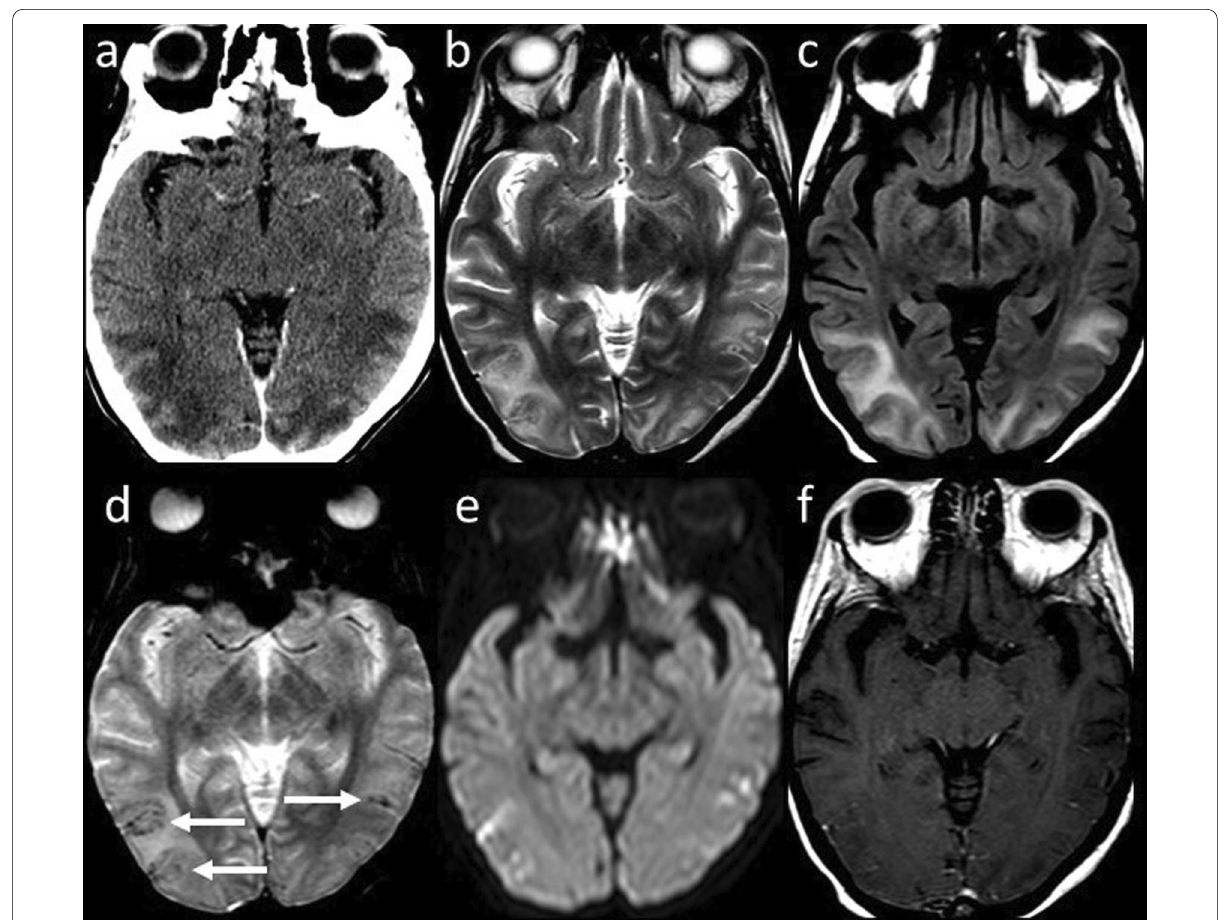
Fig. 5 Posterior Reversible Encephalopathy Syndrome. Axial contrast-enhanced CT image ( a ) of a 40-year-old woman with metastatic cervical carcinoma treated with multiple ChT agents including Cisplatin and 5-Fluorouracil shows bilateral parieto-temporo-occipital, subcortical and cortical, hypodense and non-enhancing foci. Axial T2-weighted ( b ) and FLAIR ( c ) images reveal corresponding hyperintense areas. Axial GRE T2*-weighted ( d ) image shows cortical and focal hypointense foci (arrows) related to microhemorrhages with neither diffusion abnormality on DWI ( e ) nor pathologic contrast enhancement on axial post-contrast T1-weighted image ( f